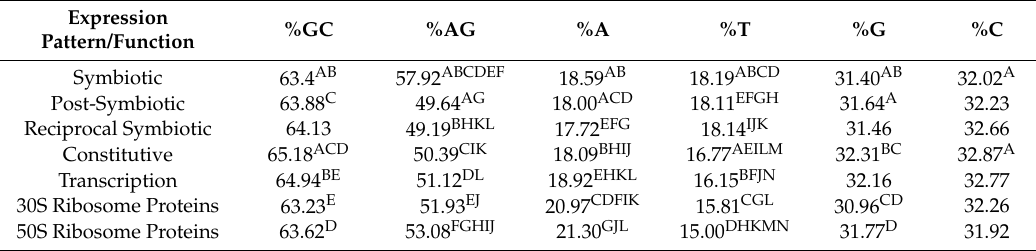
Table 6. Frequency of GC, AG, and nucleotide contents within each expression pattern and the transcription and translation functional groups. Values are frequency per 1000 codons. Superscripts indicate a statistical difference ( p < 0.5) between similar indicated